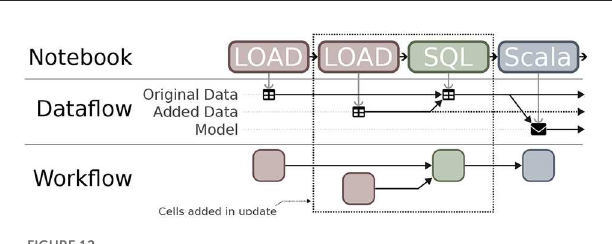
FIGURE12 Extracting dataflow and workflow provenance from notebooks.